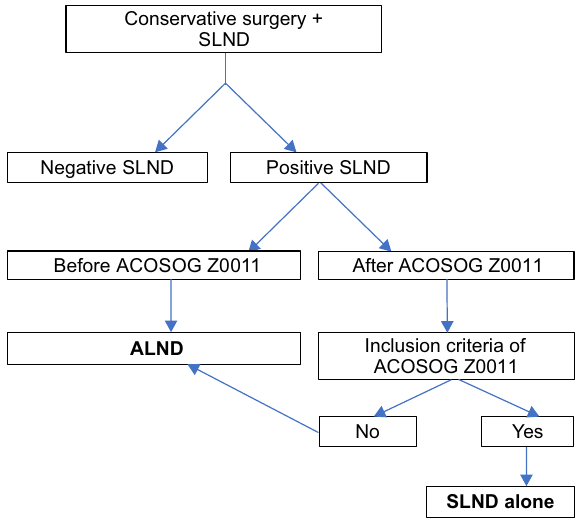
Figure 1. Clinical approach for the treatment of the axilla after the publication of the Z0011 trial. SLND sentinel lymph node dissection, ALND complete axillary lymph node